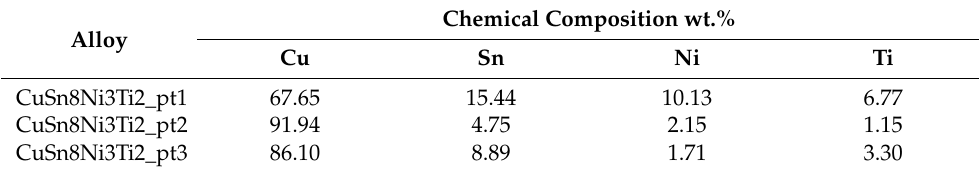
Table 7. Chemical composition EDS wt.% of CuSn8Ni3Ti2 alloy for the Figure 6d image. Figure 7. Element distribution maps for CuSn8Ni3Ti2 alloy, with separation of the intermetallic phase: ( a ) maps of ele- ments; ( b ) Cu; ( c ) Sn; ( d ) Ni; ( e ) Ti.